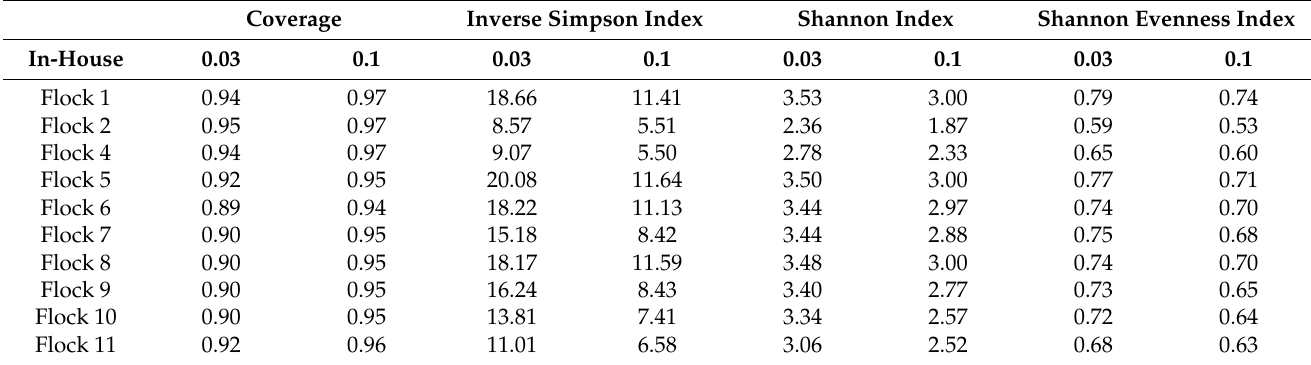
Table 1. The coverage, diversity, and evenness indices at 0.03 and 0.10 genetic distances of In-House Beetles bacteria associated with flock rotations. n = 8 composite